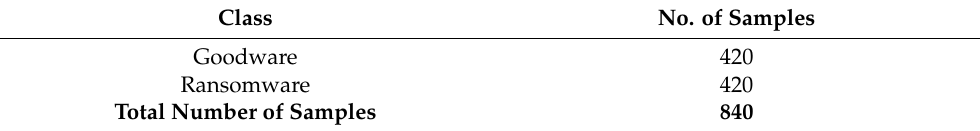
Table 1. Dataset details.